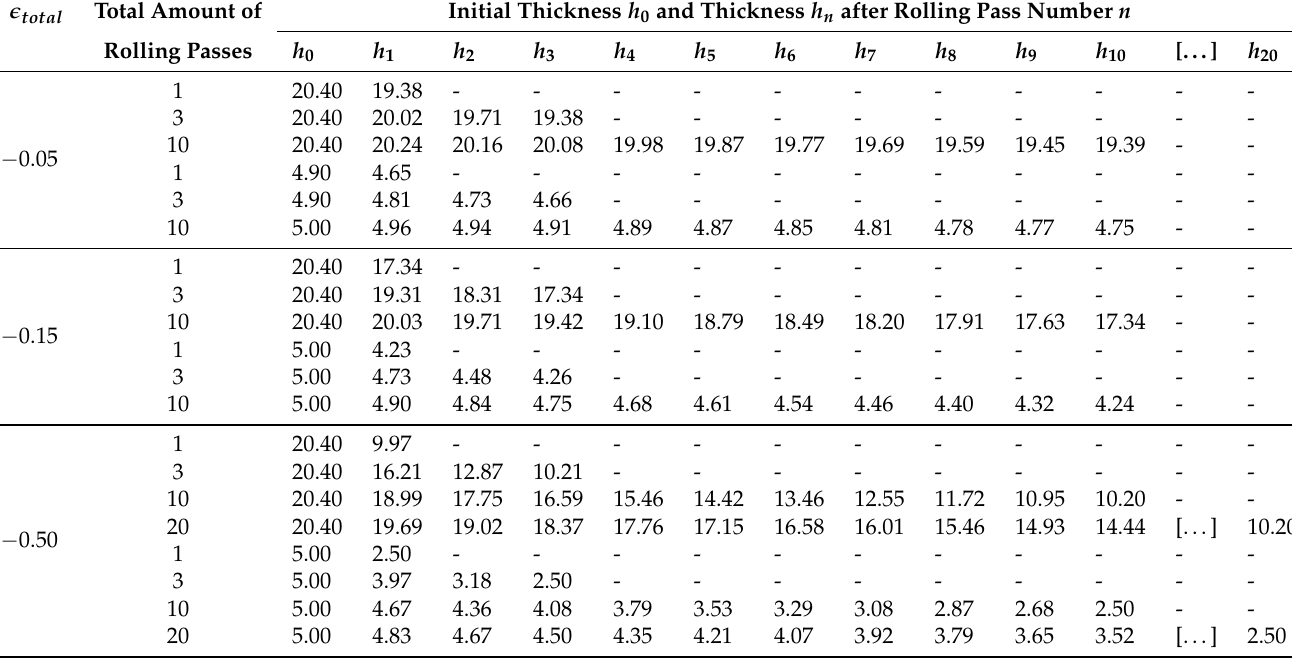
Table 2. Samples thicknesses before and after rolling for the first series of